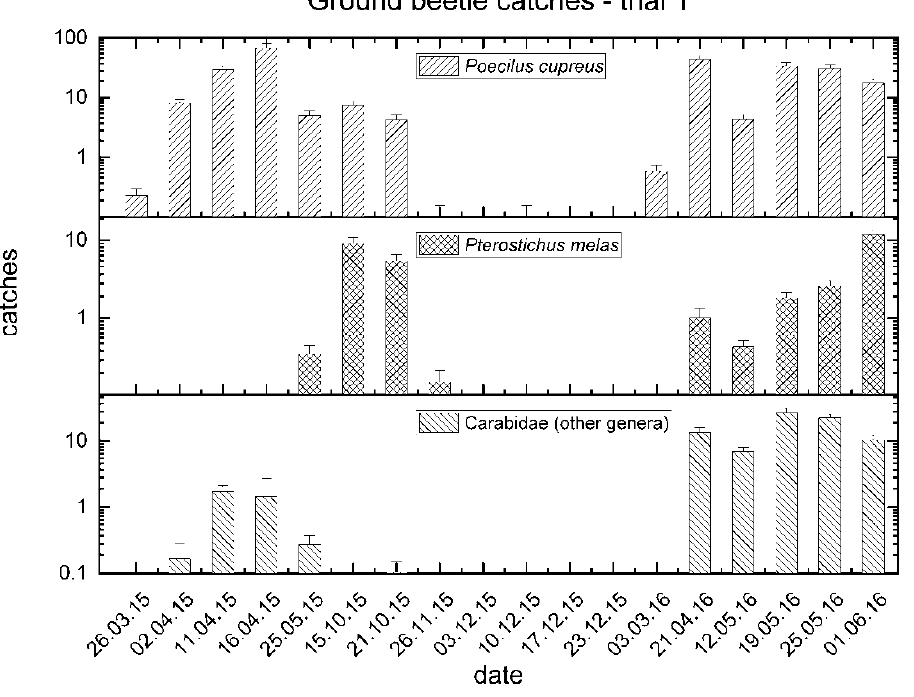
Figure 2. Mean catches of ground beetles between March 2015 and June 2016 in trial no.